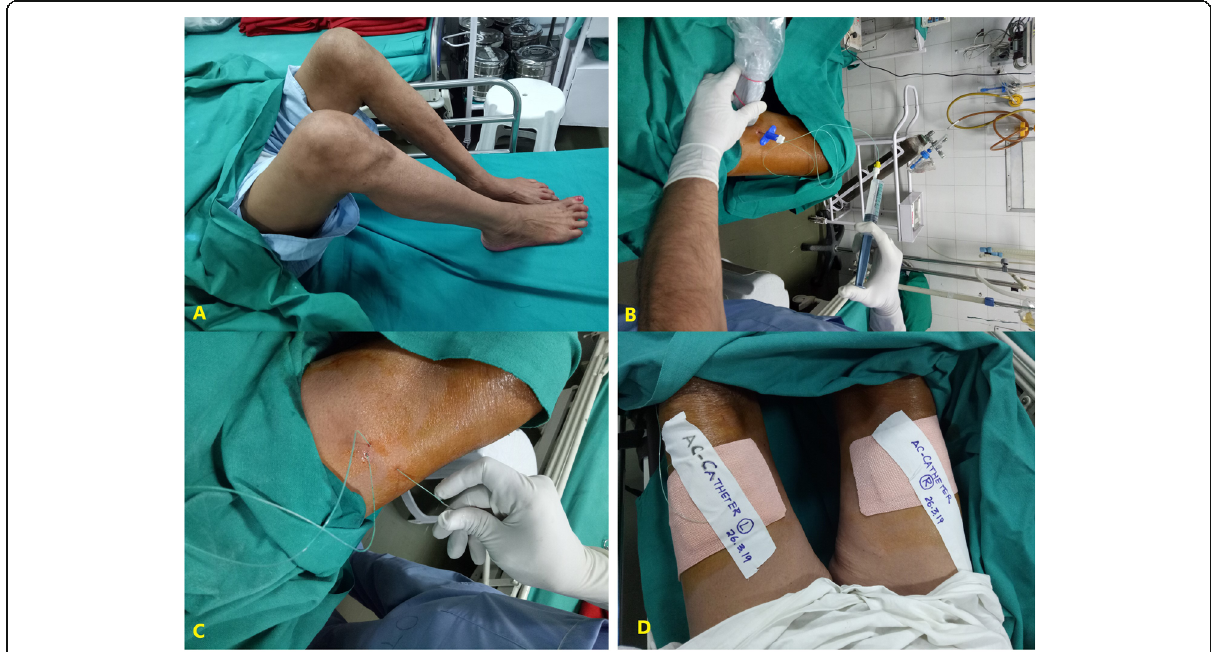
Fig. 3 a Positioning for adductor canal block, patient unable to extend the lower limbs due to flexion contracture deformity. b Observation for spread of local anesthetic after catheter insertion. c Tunnelling of catheter for stability. d Dressing and labeling of catheters for safety. A-deep femoral artery, LA-local anesthetic, AM-adductor magnus muscle, SM-sartorius muscle. VAM-vaso-adductor membrane, VM-vastus medialis